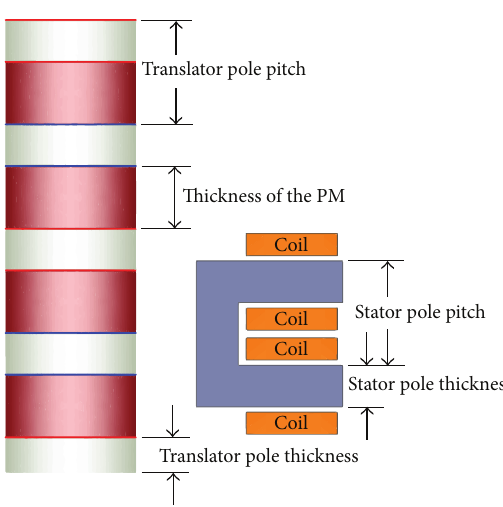
Figure 9: Stator and translator pole